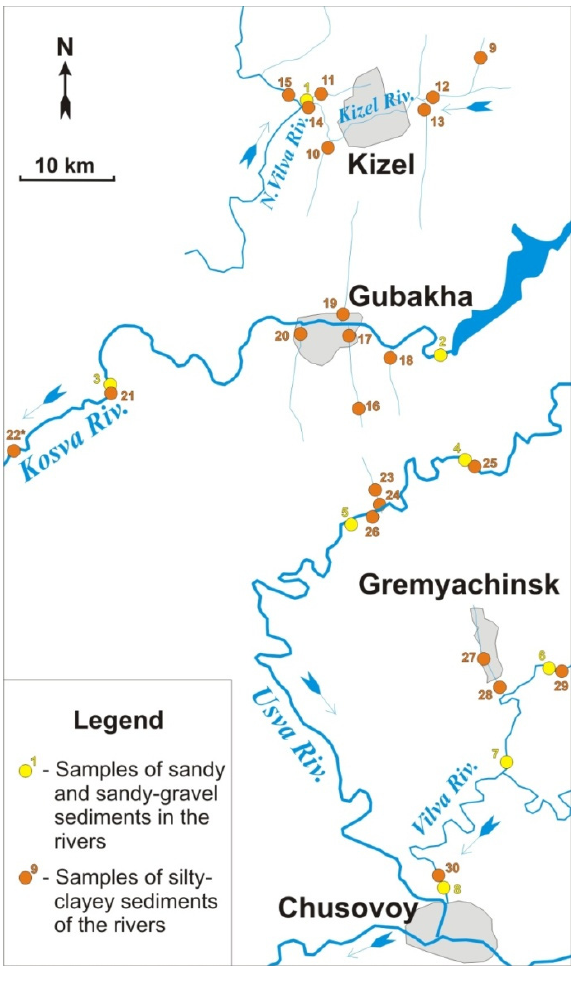
Figure 1. Scheme of sampling places.